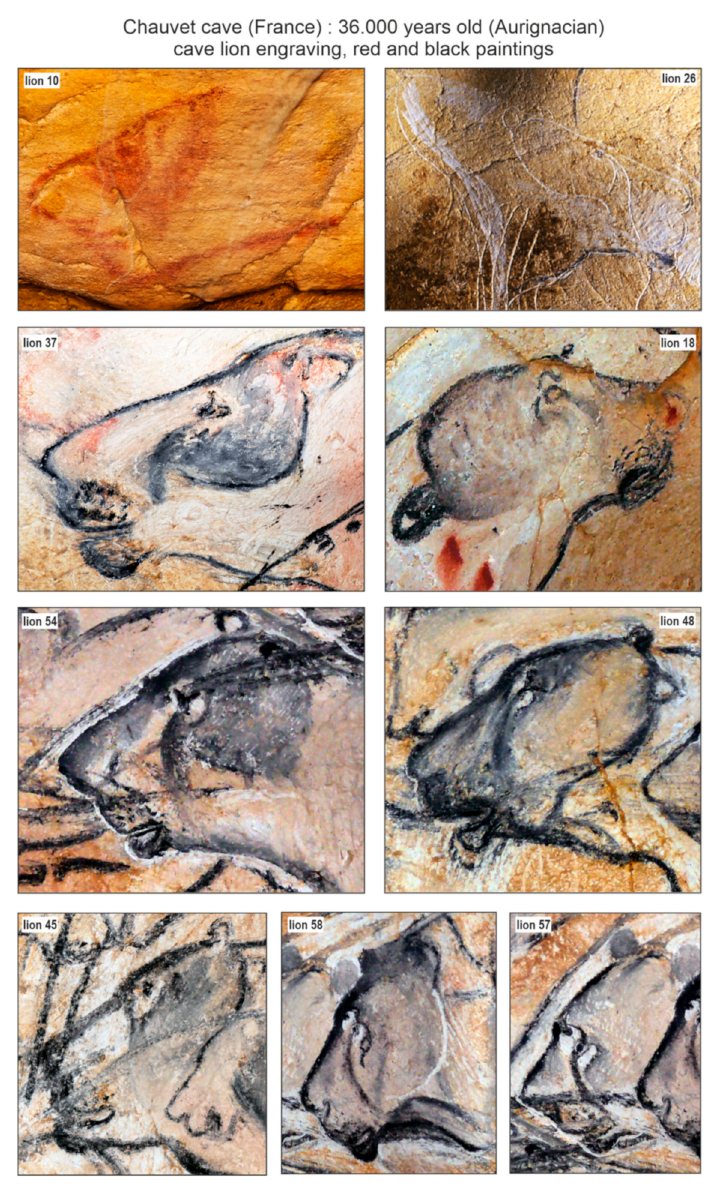
Figure 9. Selected paintings of adult cave lions from Chauvet cave, showing interesting colouration on their head fur. Pictures: P. Fosse, numbers labelled as in Clottes and Az é ma